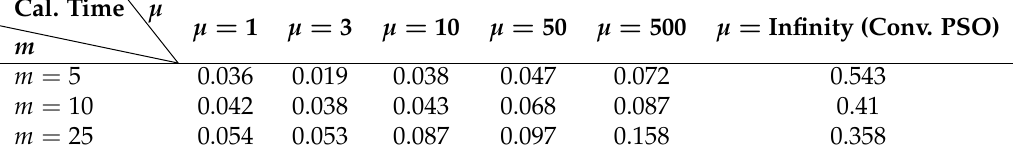
Table 1. Average calculating time with different µ and m where w = 0.4, p = 8, q = 2, N = 100,